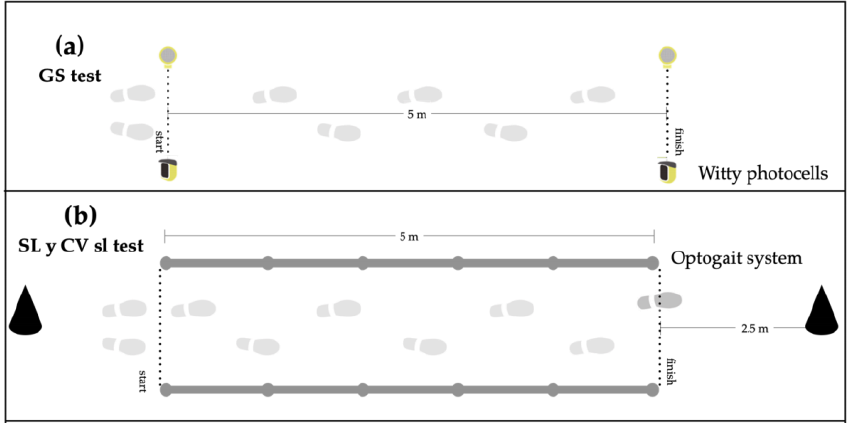
Figure 1. Gait analysis procedure. ( a ) GS: Gait speed, ( b ) SL: step length; CV sl: gait variability of SL.